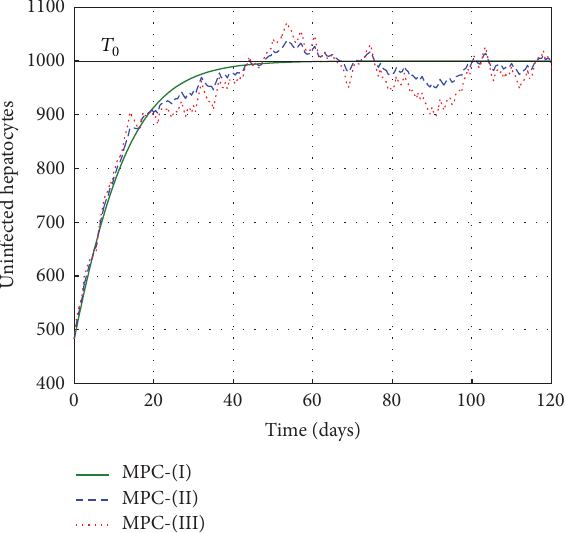
Figure 6: The evolution of free virus under